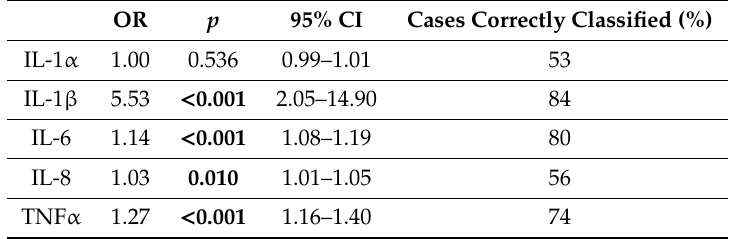
Table 3. Univariate logistic regression analysis of all cytokines investigated.